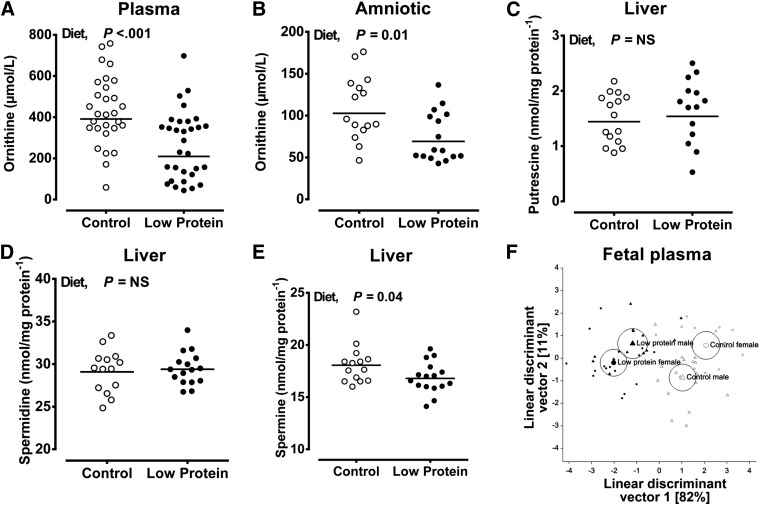
Maternal LP diet reduces the availability of ornithine in the fetal compartment and hepatic spermine concentration. A, B) Ornithine was measured in fetal plasma (A) and amniotic fluid (B) using gas chromatography-mass spectrometry (see Materials and Methods). C–E) The polyamines putrescine (C), spermidine (D), and spermine (E) were measured in lysates of fetal liver using high-performance liquid chromatography. Data are dot plots of data points from individual fetuses (A–E) with the line indicating the mean from each dietary treatment. Data were analyzed by the general linear mixed model for the fixed effects of diet, sex, and their interaction (ewe included as a random effect in the model) using Genstat 15. F) Linear discriminant plot generated after multivariate analysis of 18 amino acids in fetal plasma (circles representing 95% confidence interval around group means) conducted after normalization of data (by establishing z scores). NS, nonsignificant. Values of P < 0.05 were considered significant.